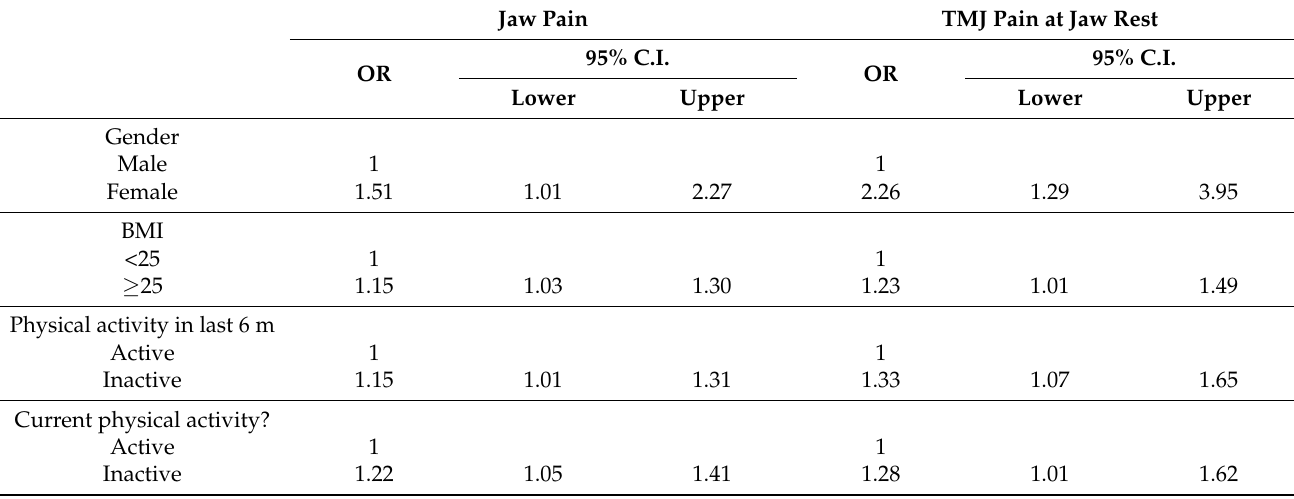
Table 2. OR and 95% confidence intervals (95% C.I.) from regression model on the association between jaw pain and TMJ pain at jaw rest and current physical activity and during the last six